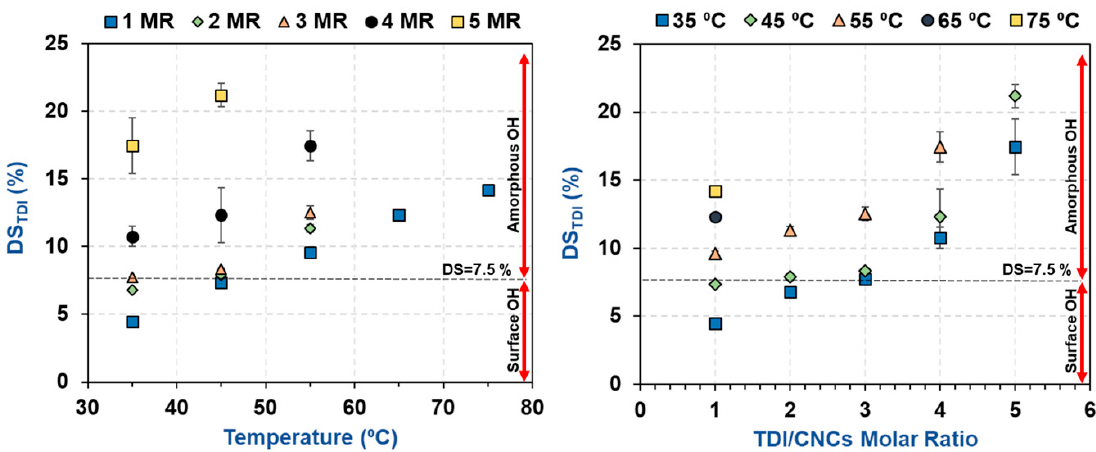
Figure 2. The impact of carbamation temperature and TDI / CNCs molar ratio on the amount of TDI reacted with CNCs, i.e., degree of TDI substitution (DS TDI ).